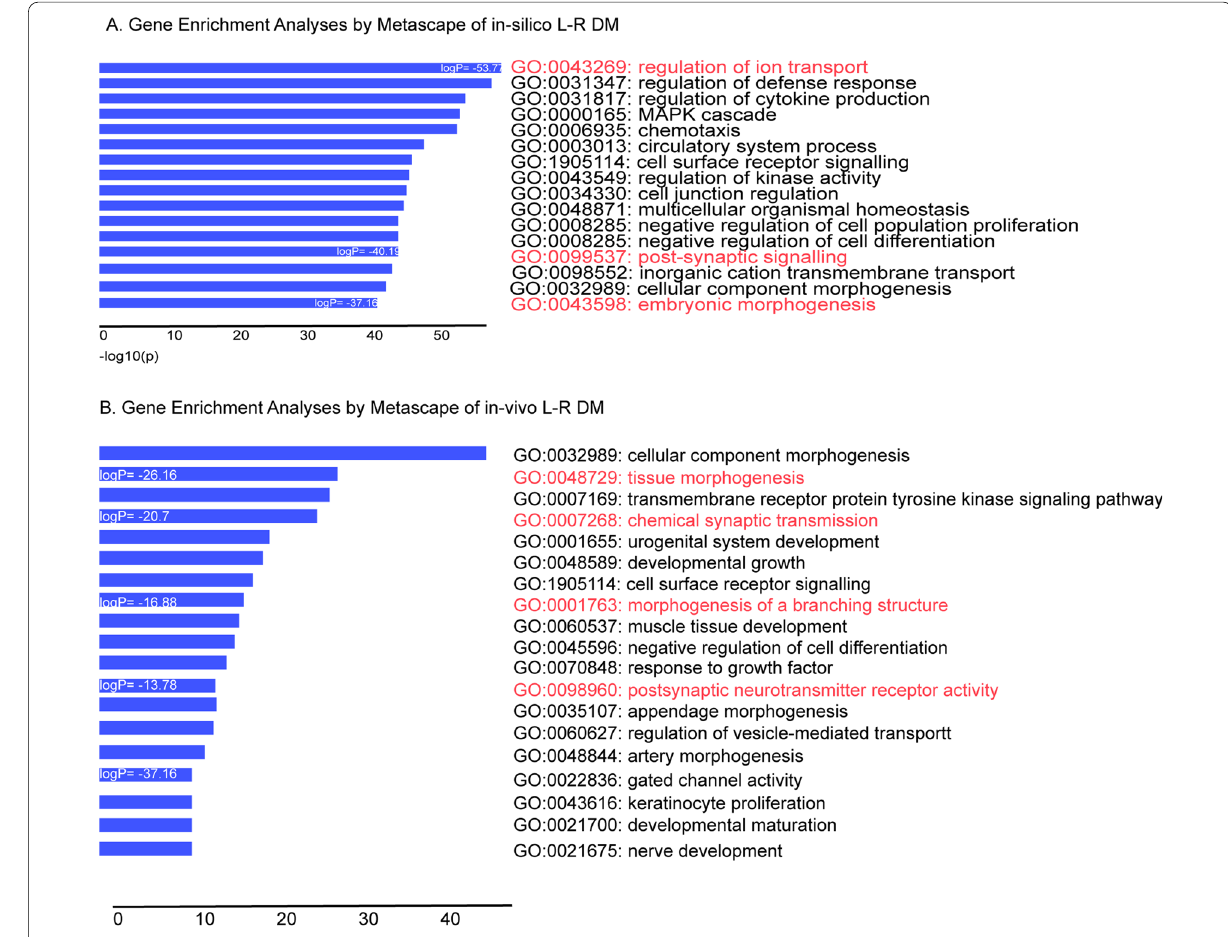
Fig. 1 Gene enriched pathways of L/R differential methylated regions. A DNA regions with more than 1% DM between L–R primary breast tumors from TCGA public dataset were analyzed by Metascape for enriched GO Biological processes (p value cut-off 0.001). B DNA regions with more than 10% DM between 6 L/R xenograft tumors were analyzed by Metascape for enriched GO Biological processes (p value cut-off 0.001). Ion/neural and embryonic pathways are highlighted in